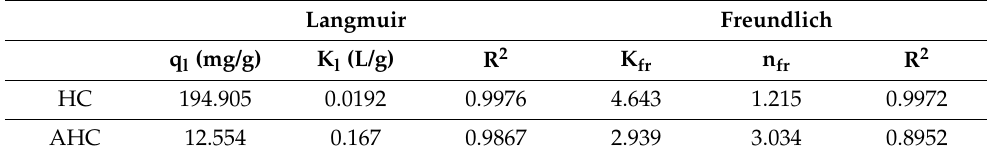
Table 1. Adsorption isotherm parameters for MB dye by HC and AHC samples. Langmuir Freundlich